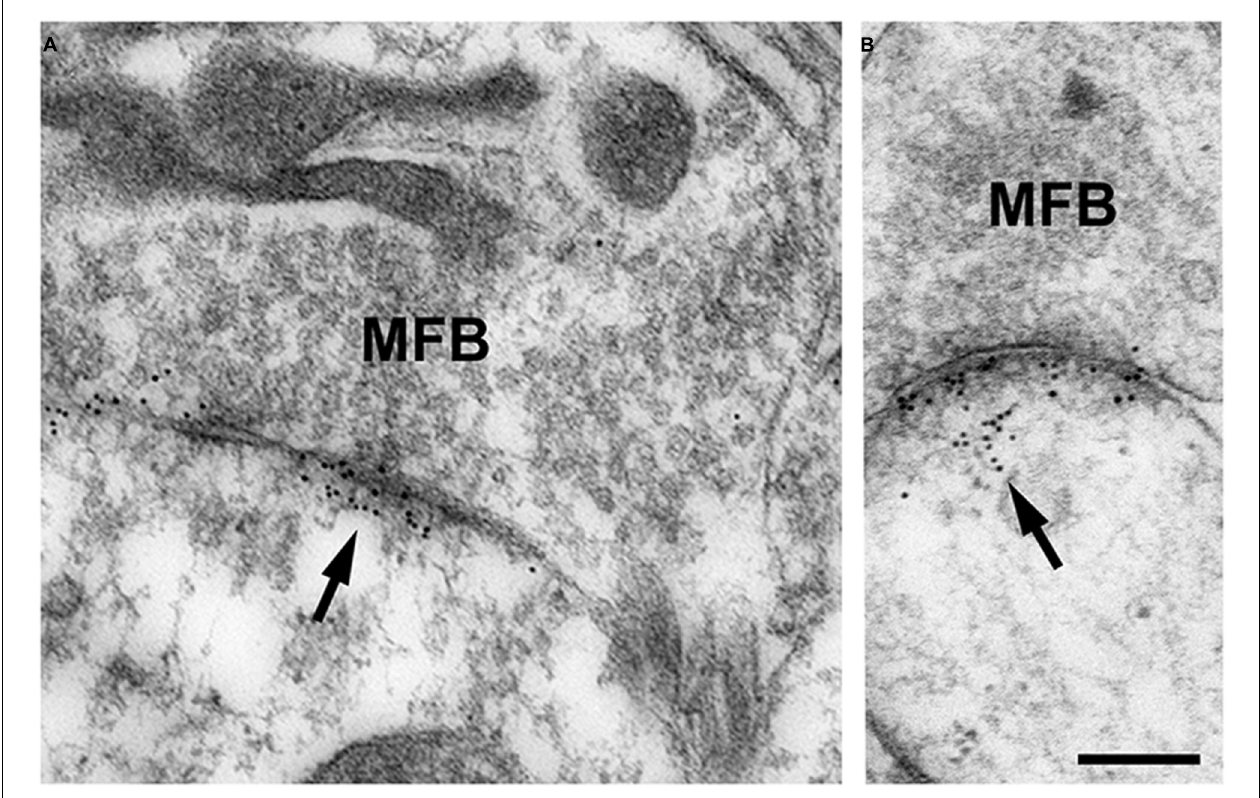
incubated in rabbit anti-p-cofilin (ser3; 1:100; Santa Cruz Biotechnology, Heidelberg, Germany); secondary antibodies were gold-labeled (goat-anti-rabbit, 10 nm gold grains; British Biocell, Cardiff, UK). Sections were post-stained with uranyl acetate and lead citrate. For control, the primary antibody was omitted; no specific staining was seen under these conditions. Scale bar: 200